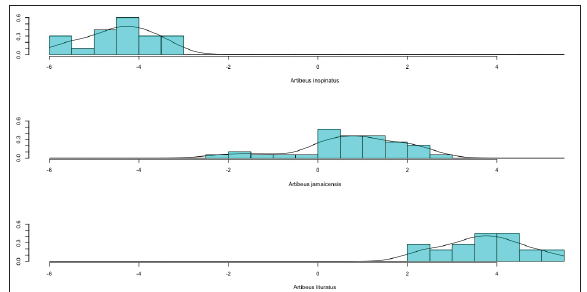
Figure 3. Column bars based on the frequency of the weights of the 648 morphometric measurements analyzed. Note a slight overlap between A. jamaicensis (second graph) and A. inopi- natus (first graph), considered by Davis (1970), and an evident overlap between A. jamaicensis and A. lituratus (third graph).